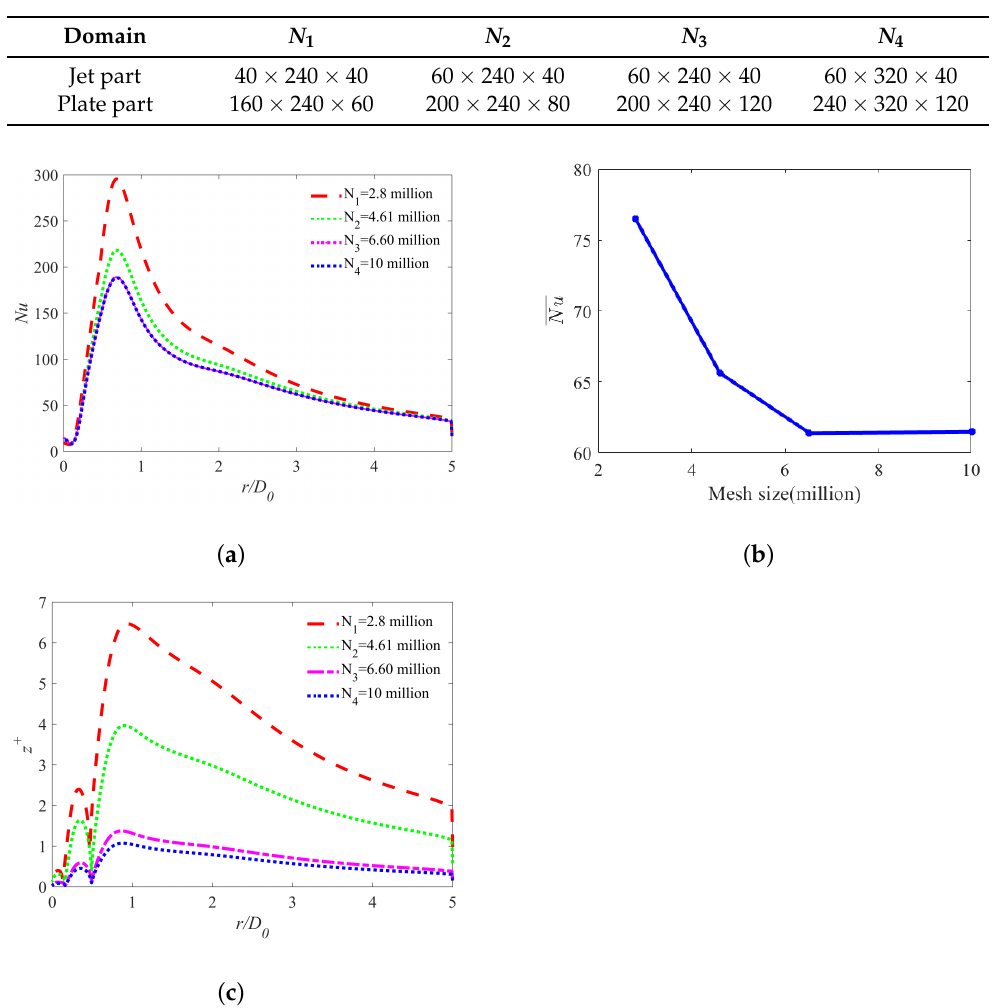
Table 1. Mesh information( r × θ × z ) of four meshes.